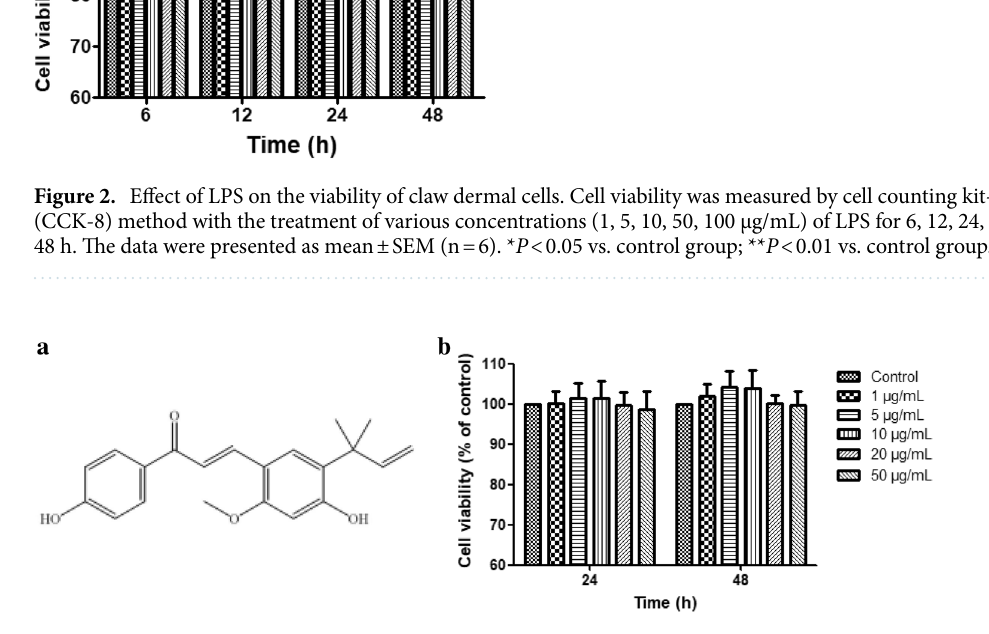
Figure 3. Cytotoxic activity of licochalcone A treatment for 24 h and 48 h on claw dermal cells. ( a ) The chemical structure of licochalcone A. ( b ) Cytotoxic effect was measured by cell counting kit-8 (CCK-8) method with the treatment of various concentrations (1, 5, 10, 20, 50 μg/mL) of licochalcone A for 24 h or 48 h. The data were presented as mean ± SEM (n =